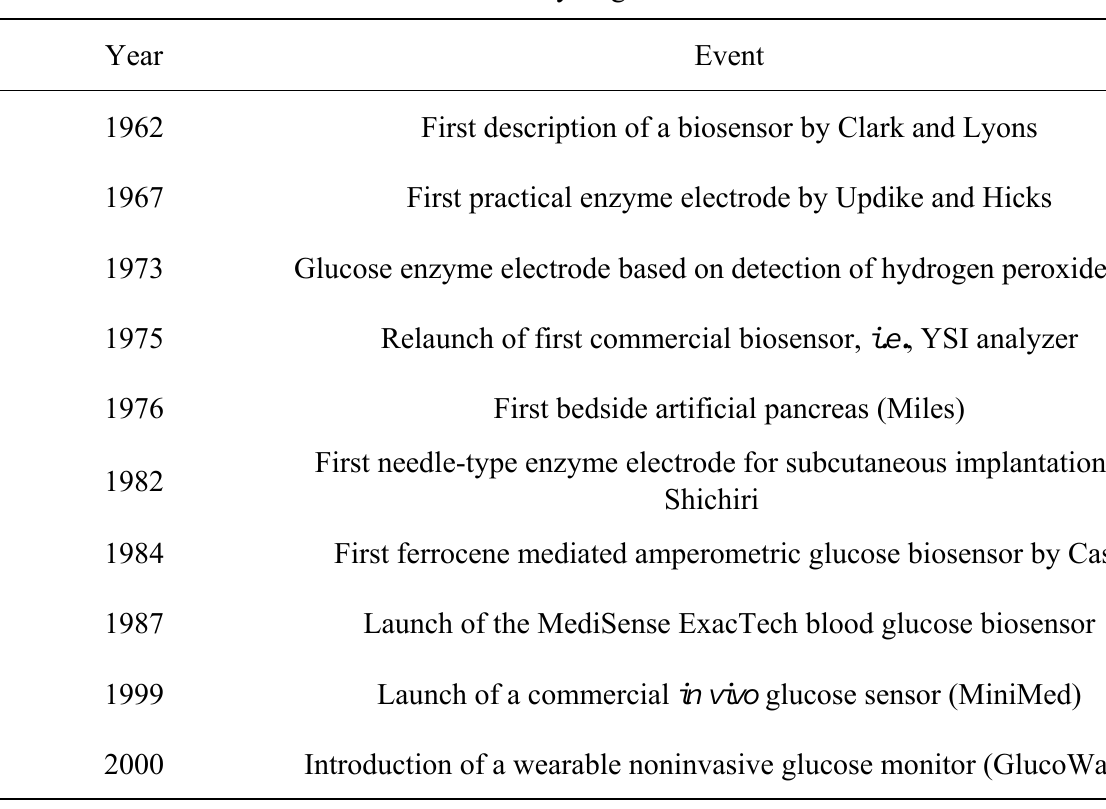
Table 1 . History of glucose